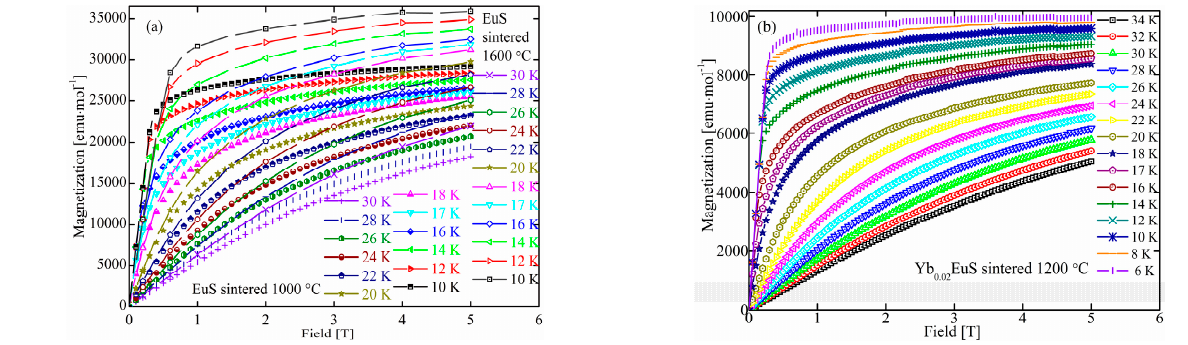
Figure 3. Magnetization of polycrystalline undoped EuS ( a ) and Yb-doped EuS ( b ) as a function of the field.